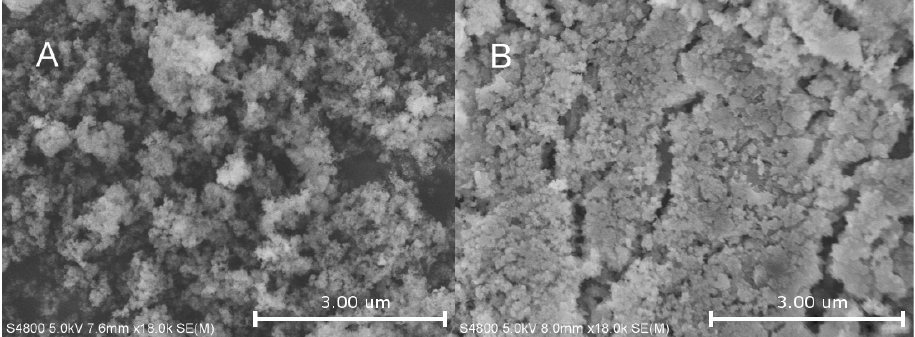
Figure 2. SEM images of the Rh/nano-SiO hydroformylation